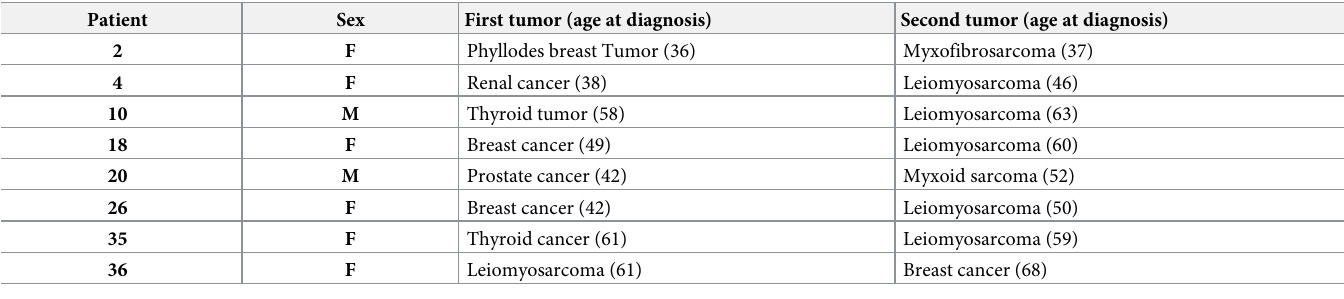
Table 3. Patients with multiple